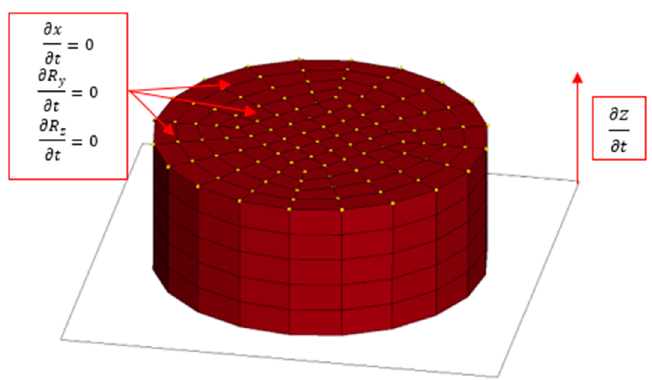
Figure 14. Scheme of the initial boundary conditions applied in the